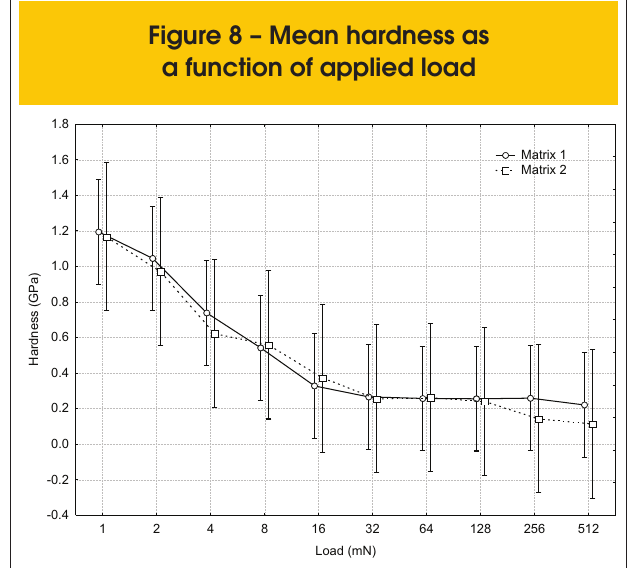
Figure 8 – Mean hardness as a function of applied load